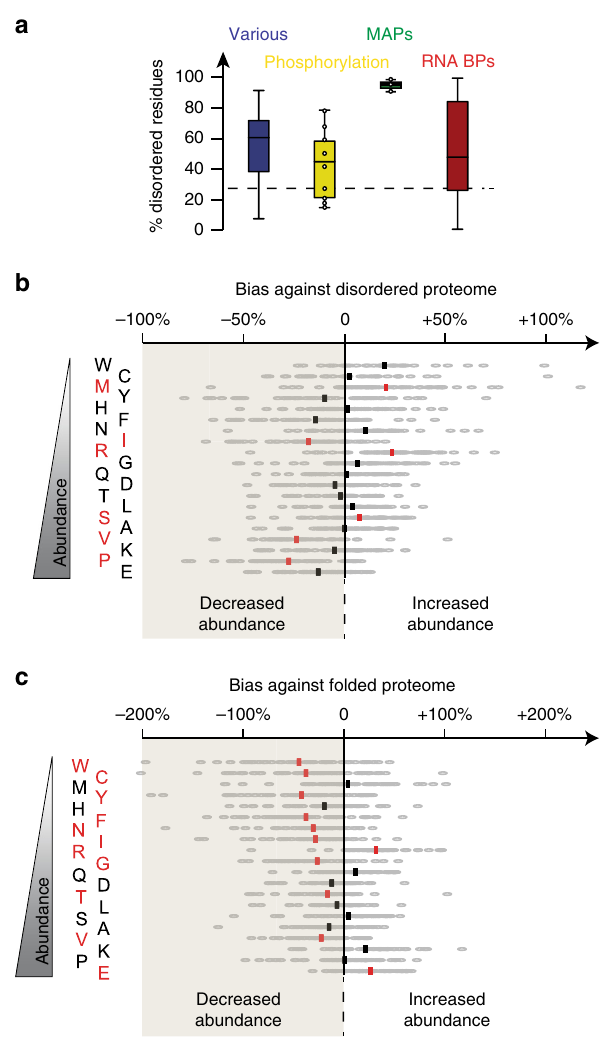
Fig. 3 Tau aggregation-speci fi c interactors are enriched in disordered sequences. a Prediction of percentage of disordered residues of Tau-RD* fi bril-speci fi c interactors (timepoint 24 h) using MetaDisorder 29 , sorted by functional clusters (same color-code of Fig. 2) and represented as box plot (box comprises fi rst to third quartiles, whiskers indicate maximum and minimum values). Dashed line indicates the average disorder percentage for human proteome 68 . Dots indicate individual proteins when cluster has n < 10. b Amino-acidic footprint of disordered regions of Tau-RD* fi bril- speci fi c interactors, expressed in fold-changes against the abundance of each amino acid in the disordered regions of the whole human proteome 68 (red, p ≤ 0.0001). Amino acids on the y -axis are sorted by abundance in the disordered proteome. c As in b , but against folded regions of the whole human proteome 31 (red, p ≤ 0.0001). Amino acids on the y -axis are sorted by abundance in the disordered proteome, for comparison with b